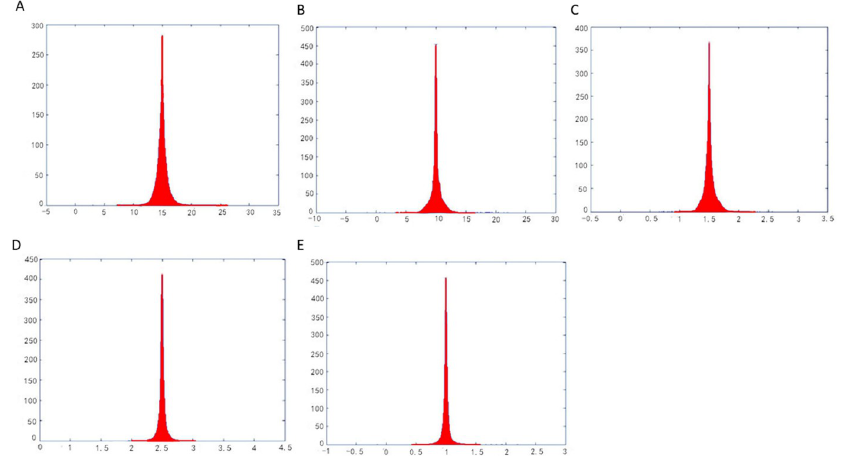
Fig 15. Histograms of area distortions on the beetle model. (A) result by LABF, (B) result by LQHP, (C) result by IQCP,(D) result by QCTM, (E) result by our method.